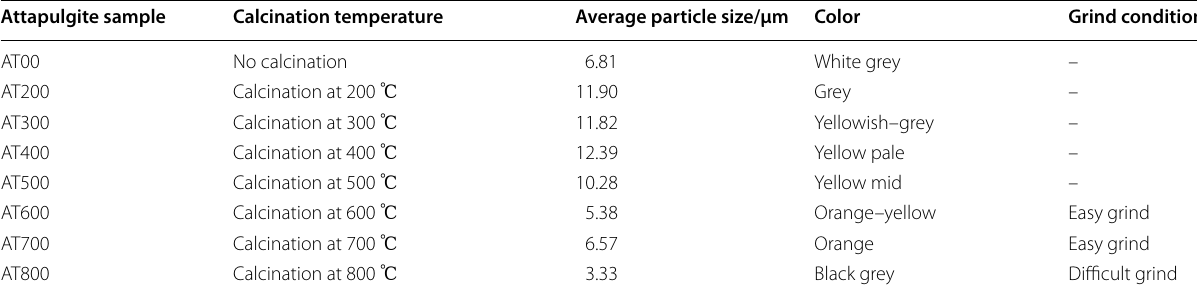
concentration and mass fraction of 2